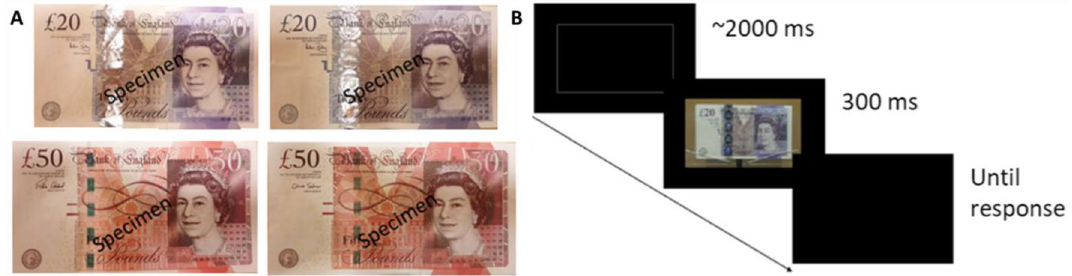
Figure 6. ( A ) Example Images of the genuine (left) and counterfeit (right) GBP £20 (top) and £50 (bottom) notes. ( B ) Trial sequence in the Authentication Task. The trial image of the £20 note is a still from a video clip showing a genuine note. The word “specimen” was never present during the